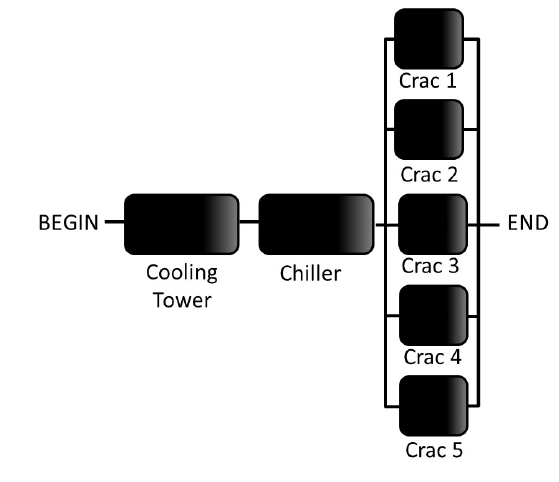
Figure 13. RBD model of the Tier I cooling